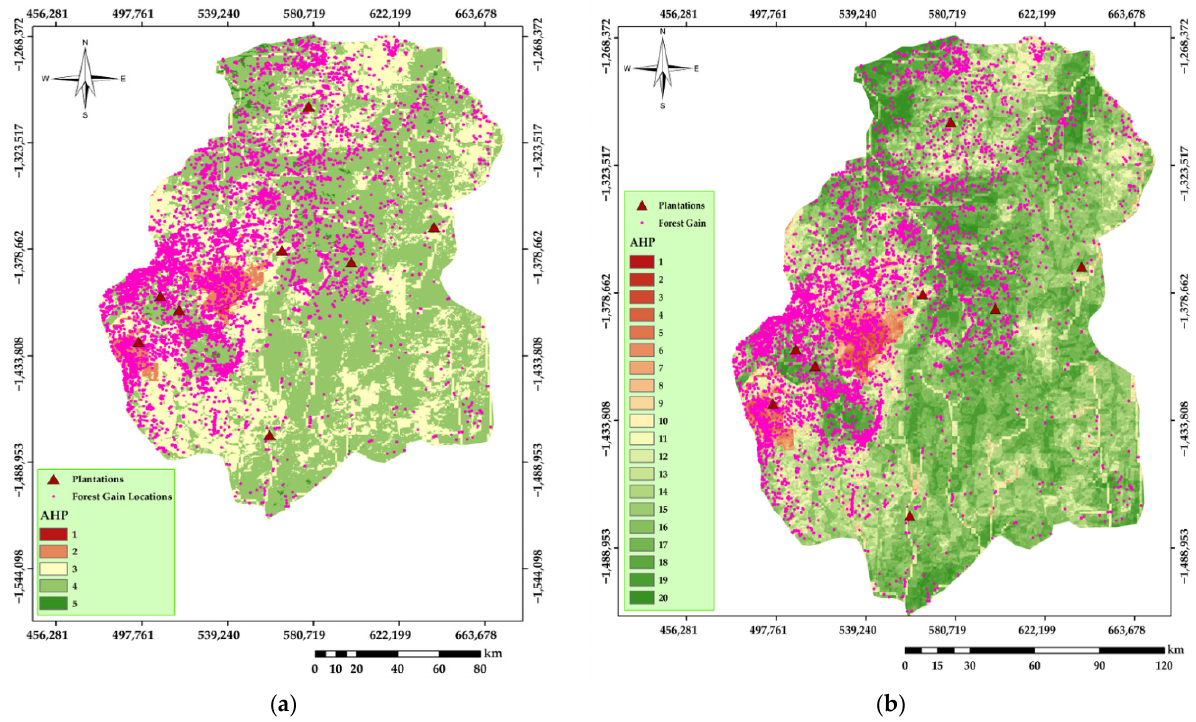
Figure 10. ( a ) Road suitability map based on AHP model automatic classification of 5 classes and ( b ) manual classification using 20 classes. Map ( b ) shows the enhanced level of detail used to propose potential areas for the construction of new routes.